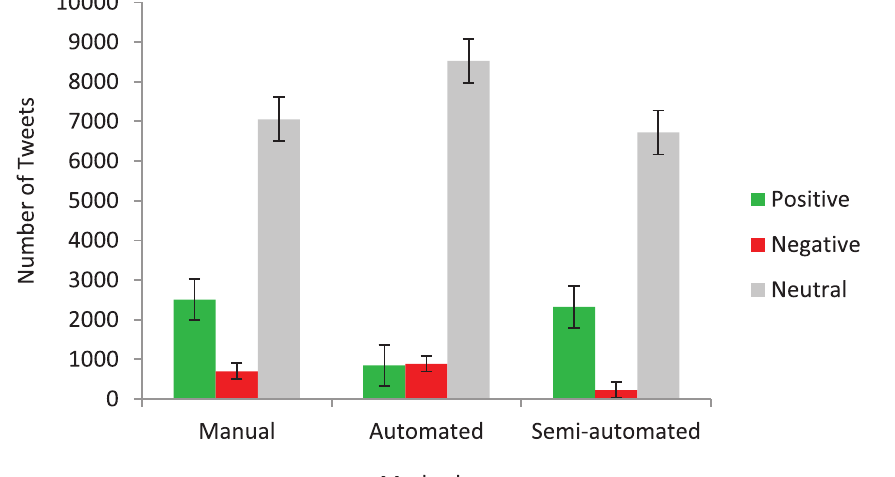
Figure 3. The number of tweets assigned by each method into positive, neutral and negative categories with standard error bars displayed. N (Number of tweets analysed) = 10268, for all methods. Table 1. The percentage (%) of tweets assigned by each method to positive, neutral and negative categories. Manual